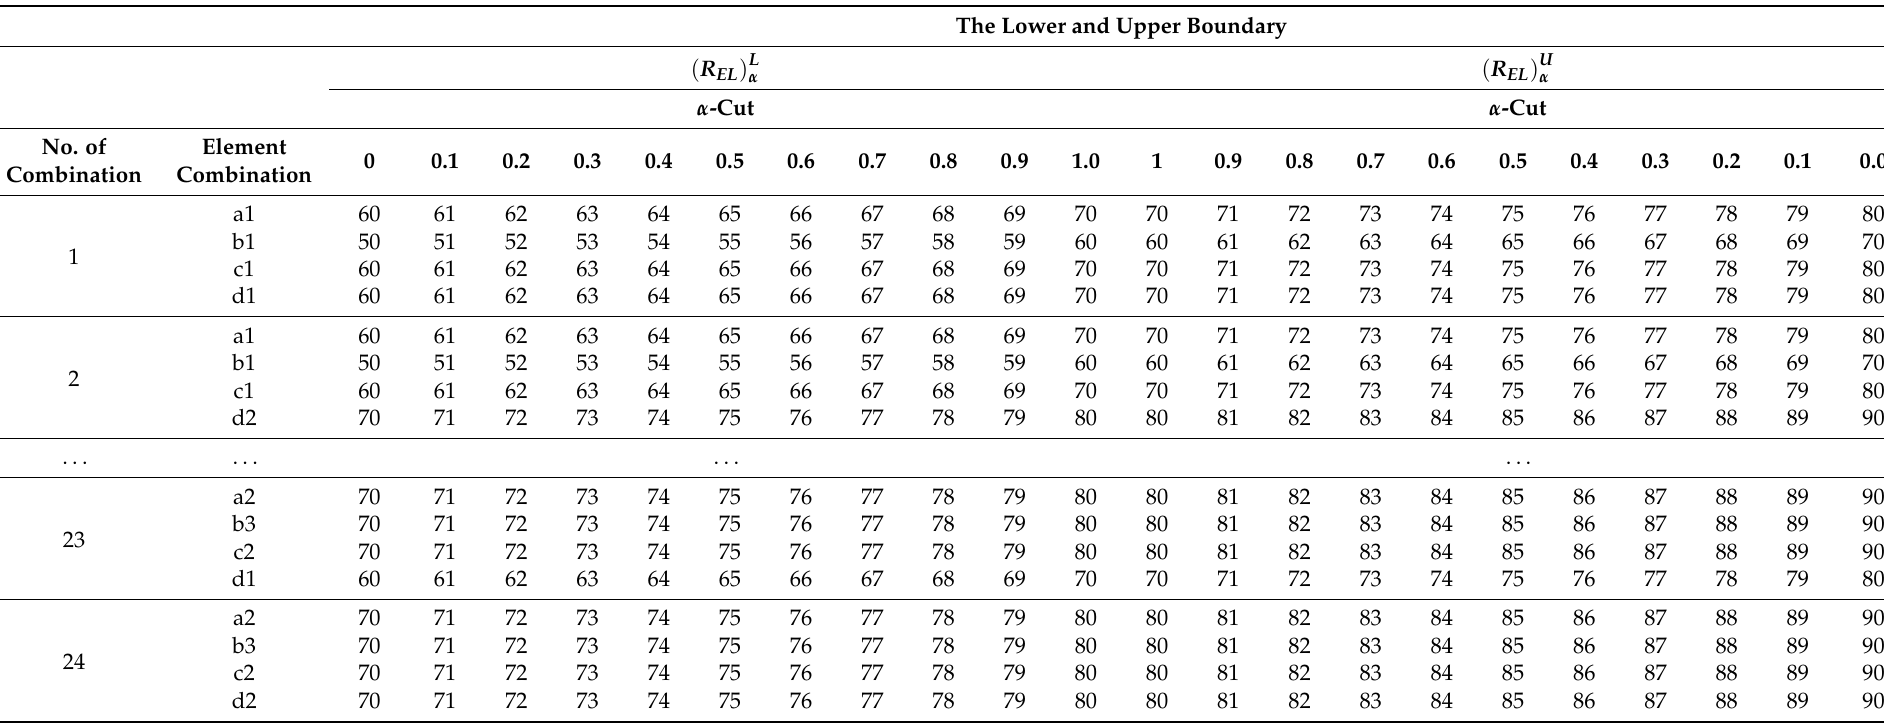
Table 6. The α -cut sets of elements fuzzy ratings according to each combination (shortened version-the first and the last two combinations).